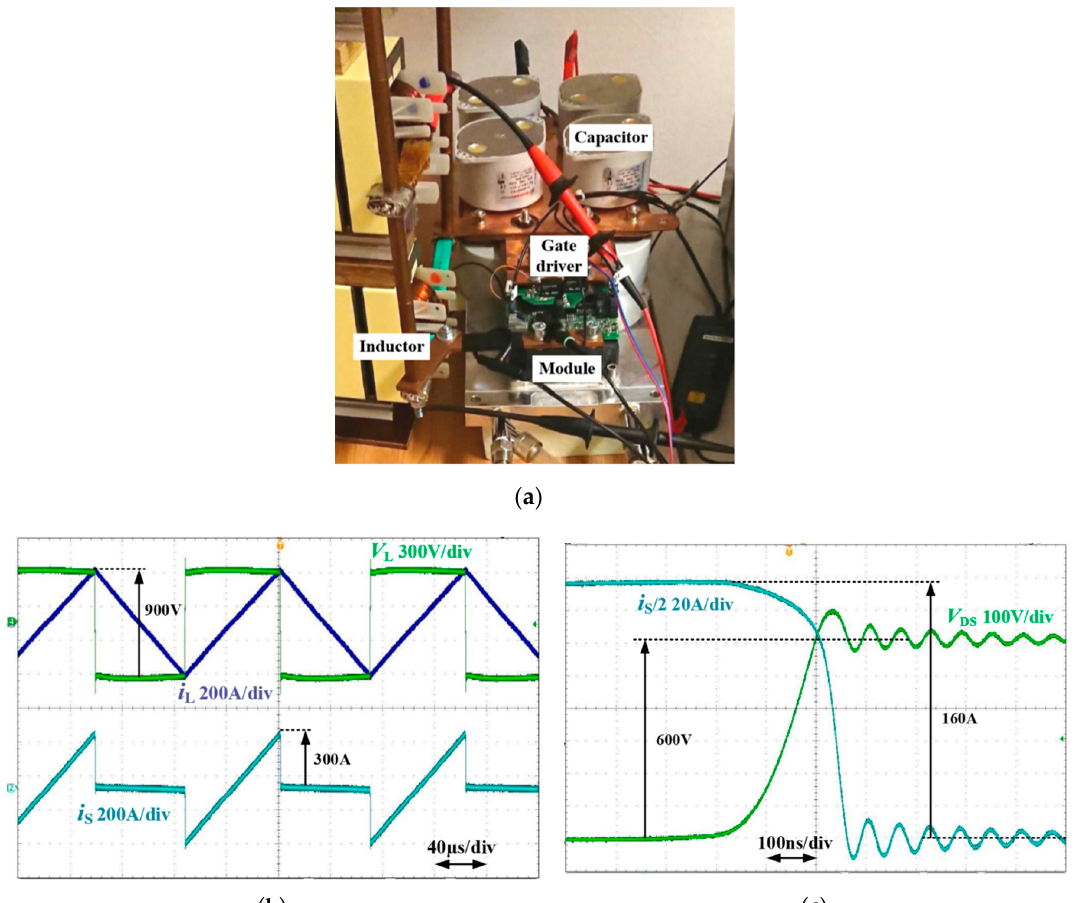
Figure 6. Photo of the half-bridge with 3.3 kV SiC MOSFET modules ( a ) and the selected waveforms recorded during the operation: inductor voltage ( v L ) and current ( i L ) together with the switch current ( b ) half of the upper switch (transistor) current with drain-source voltage ( c ).